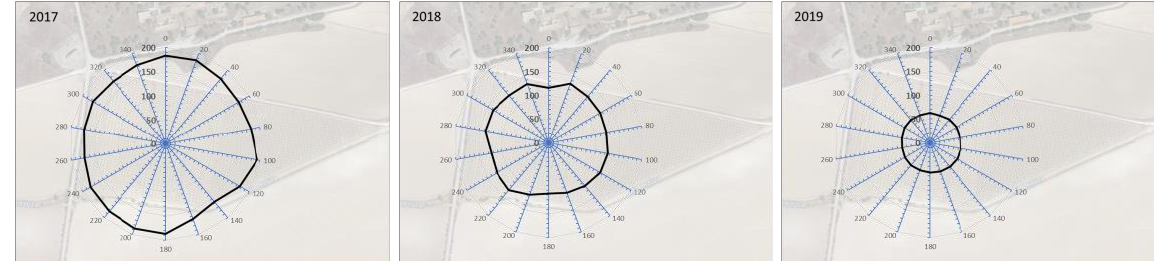
Figure 3. Polar plots showing the average footprint for the different wind directions. Plots are centered at the location of the flux tower and overlaid to an aerial view of the study site.